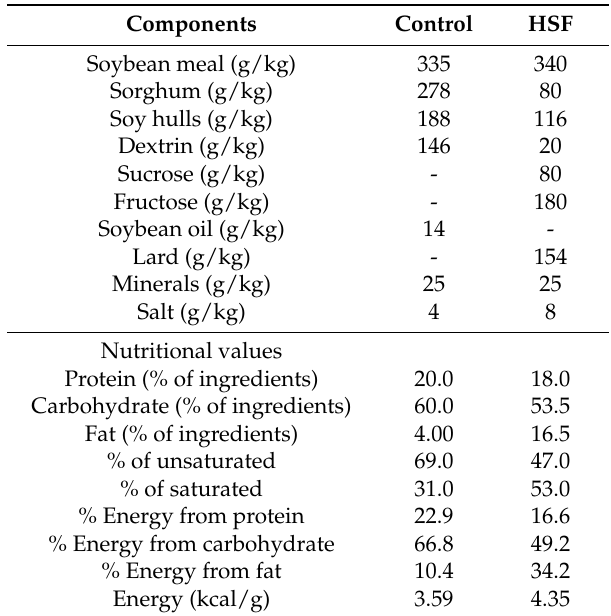
Table 1. Diet composition and nutritional